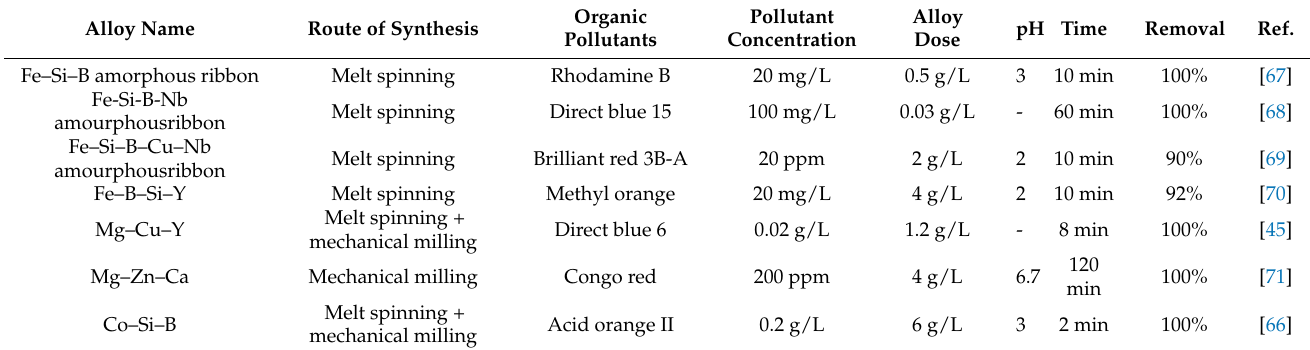
Table 2. Azo dye degradation with amorphous alloys.